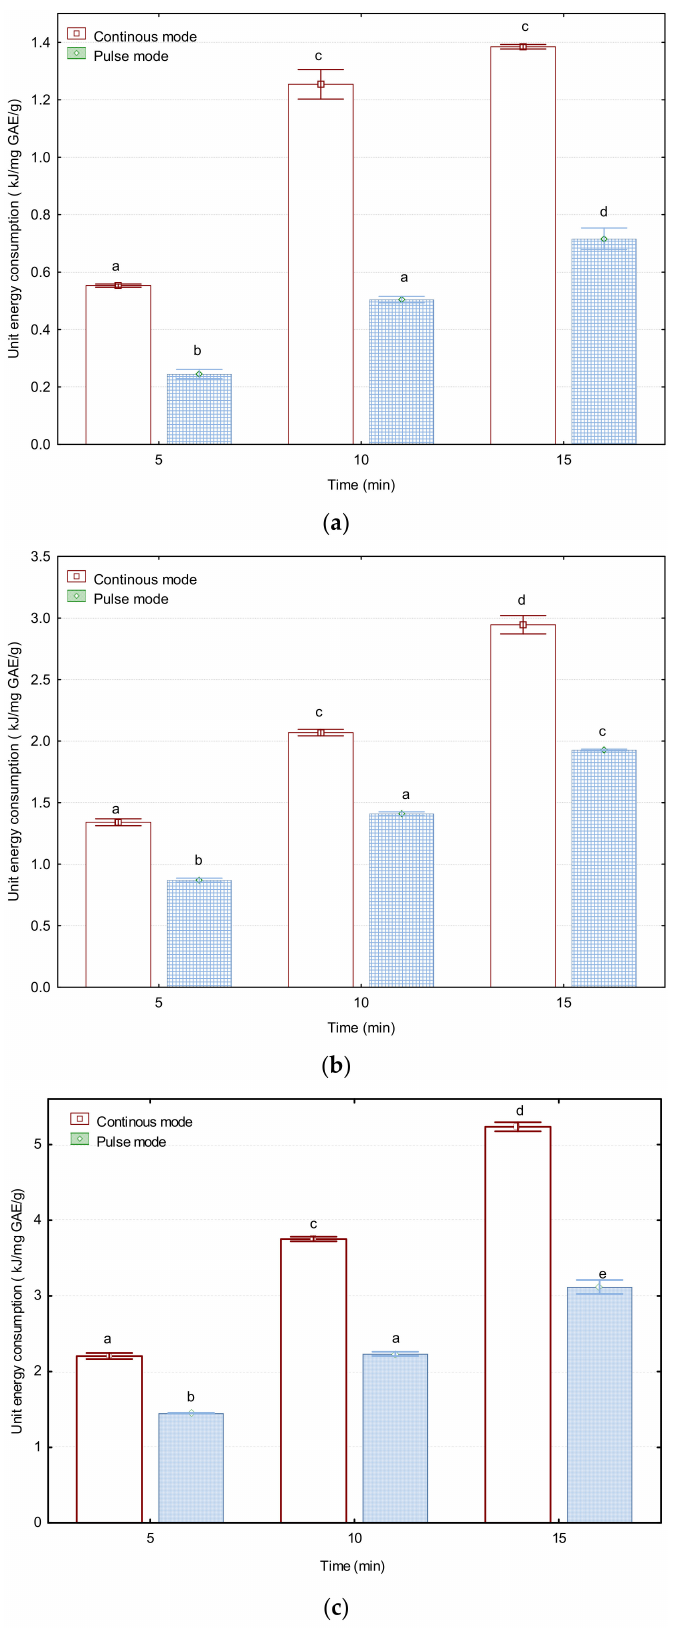
Figure 4. Impact of ultrasonic treatment parameters on the unit energy inputs during the extraction of polyphenols from hawthorn berries: ( a ) amplitude 12 µ m, ( b ) amplitude 24 µ m, ( c ) amplitude 36 µ m. The bars marked with the same letter are not statistically significantly different ( p <